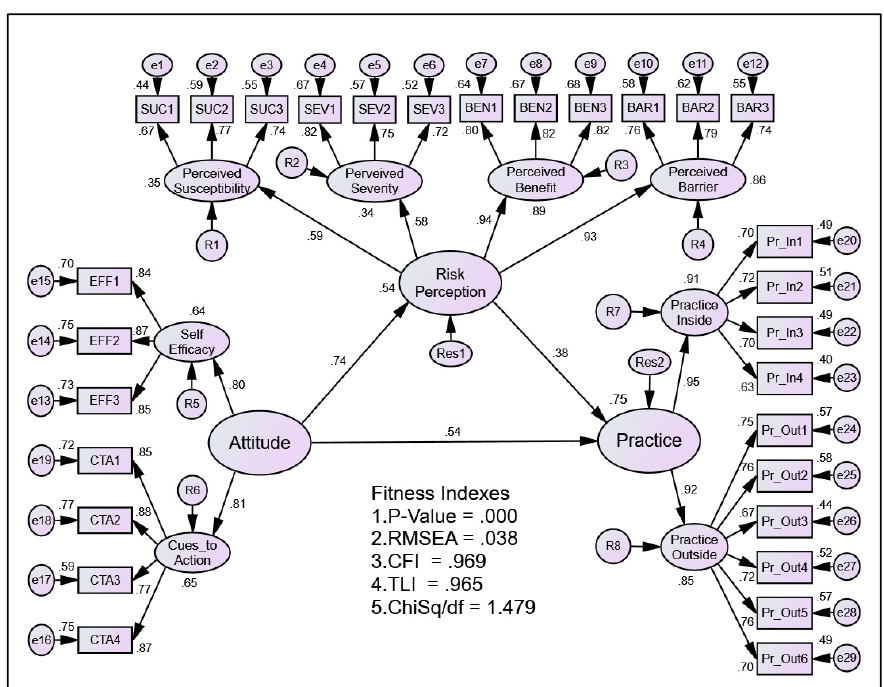
Figure 4. The results for standardised regression coefficient between constructs.